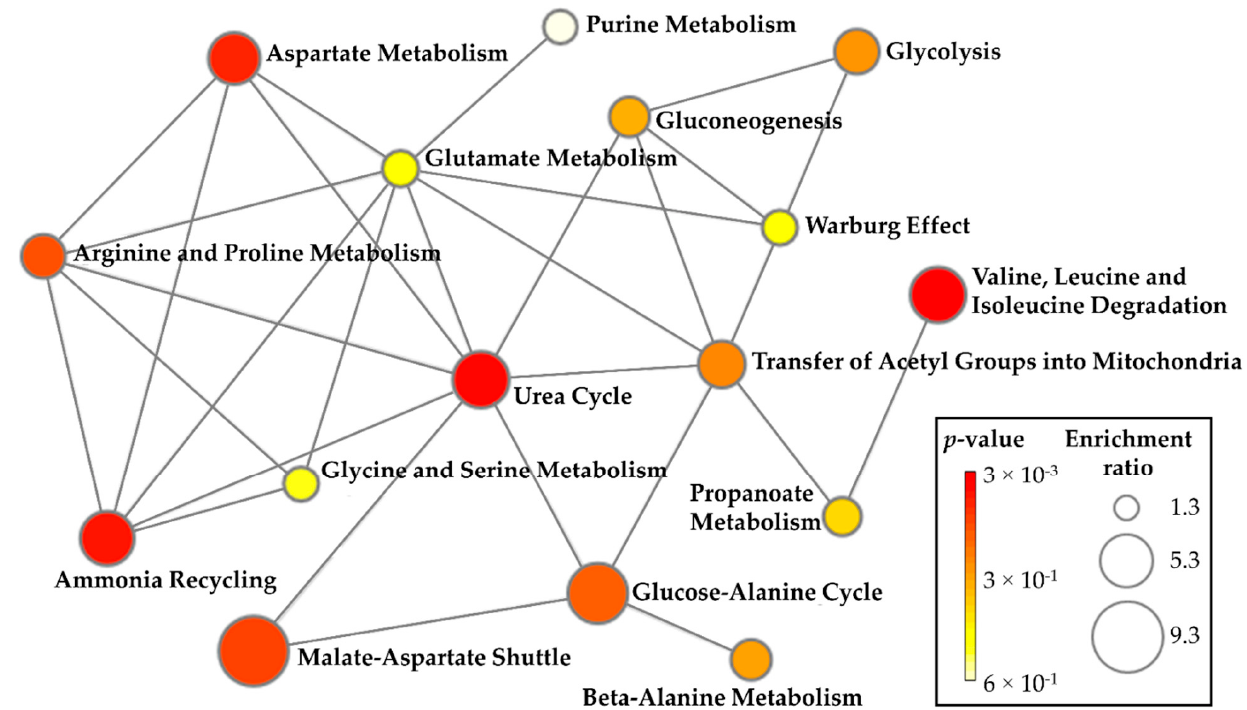
Figure 2. Metabolite Set Enrichment Analysis. The size and color (varying from red to white) of each circle represent the pathway enrichment ratio (computed by Hits/Expected hits) and p -value, respectively. The most enriched pathways enjoying connections were labeled.